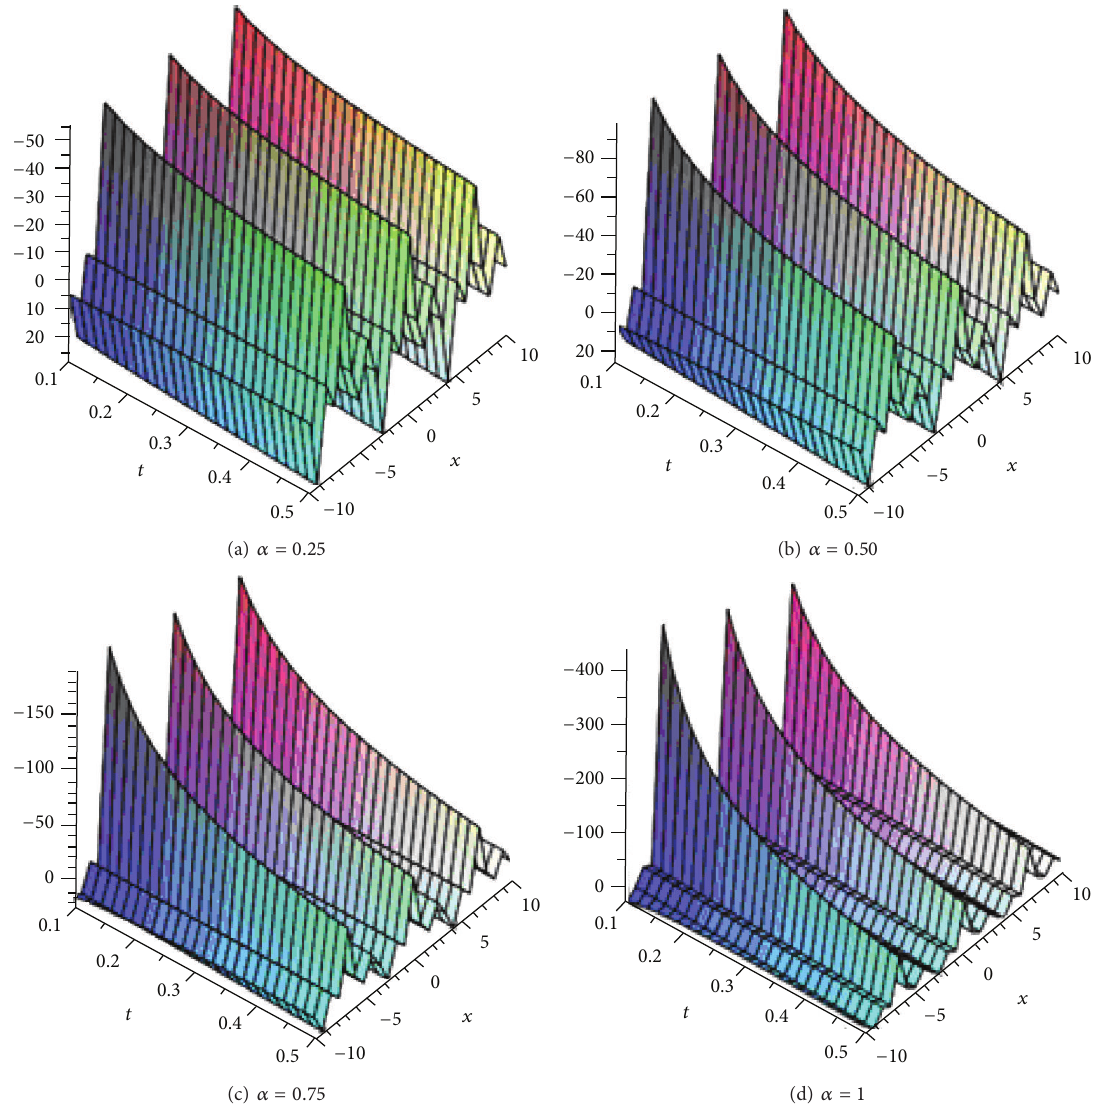
Figure 4: (a)–(d) show singular kink solution for 𝑢 12 3 for different values of